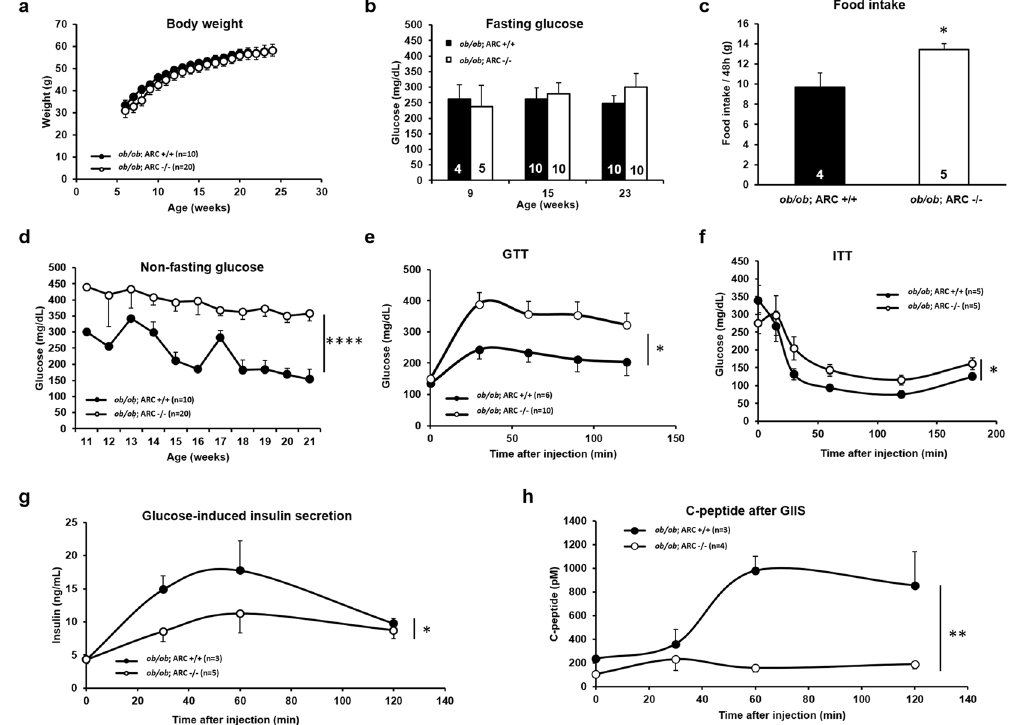
Figure 3. ob/ob; ARC − / − mice exhibit hyperglycemia, glucose intolerance, β -cell dysfunction, and hyperphagia. ( a ) Body weights. ( b ) Fasting blood glucose concentrations. ( c ) Food intake over 48 h. ( d ) Non-fasting blood glucose concentrations. ( e ) Glucose tolerance test (GTT). ( f ) Insulin tolerance test (ITT). ( g ) Glucose-induced insulin secretion (GIIS). ( h ) Plasma C-peptide during GIIS. * P < 0.05. ** P < 0.01. **** P < 0.0001. Area under the curve measurement was performed on the first three time points for panel